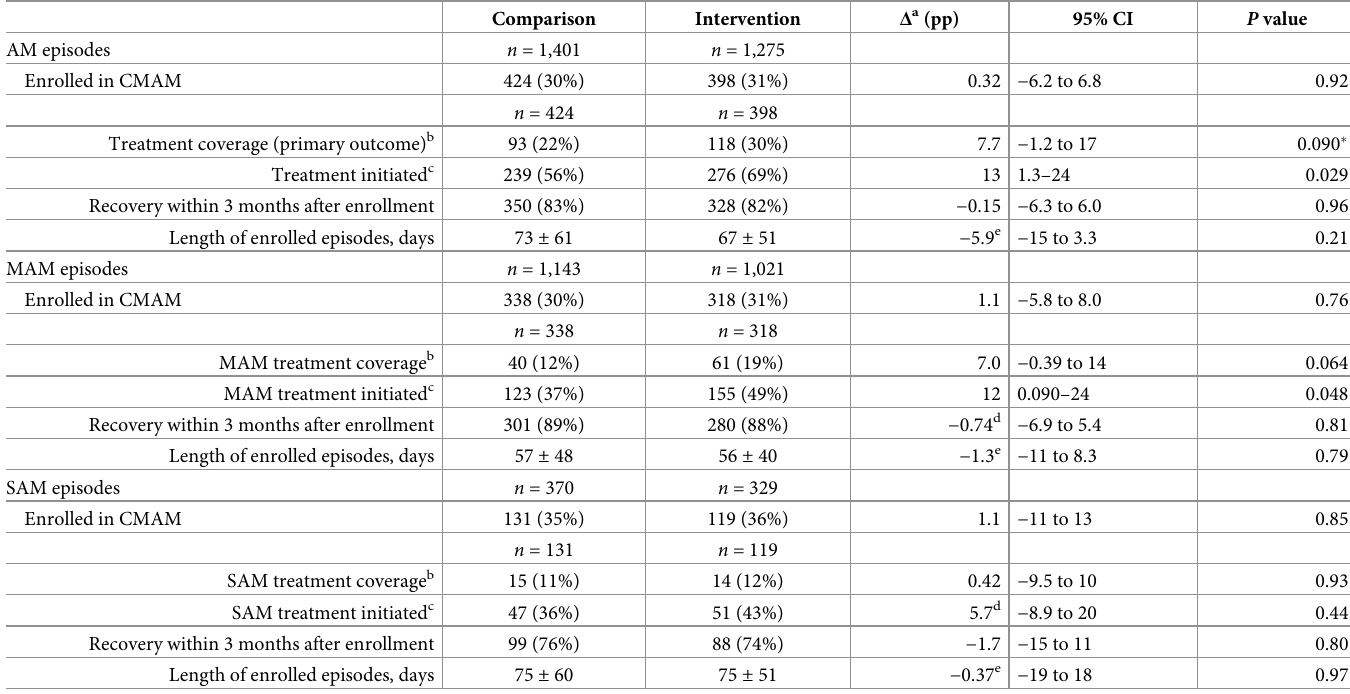
Table 6. Effect of the intervention on CMAM enrollment, treatment, and recovery outcomes for AM episodes in the longitudinal study. Comparison